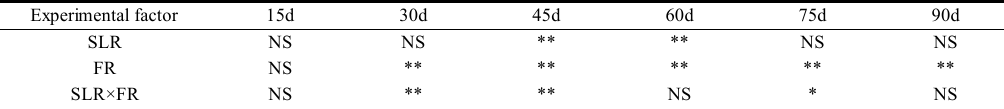
Figure 5. Effects of SLR and FR on the chlorophyll SPAD value. Note: Bars represent means ± standard deviation ( n = 3) with different letters indicating significant differences based on LSD ( p ≤ 0.05). SLR, sugarcane leaf return; FR, fertilizer reduction.